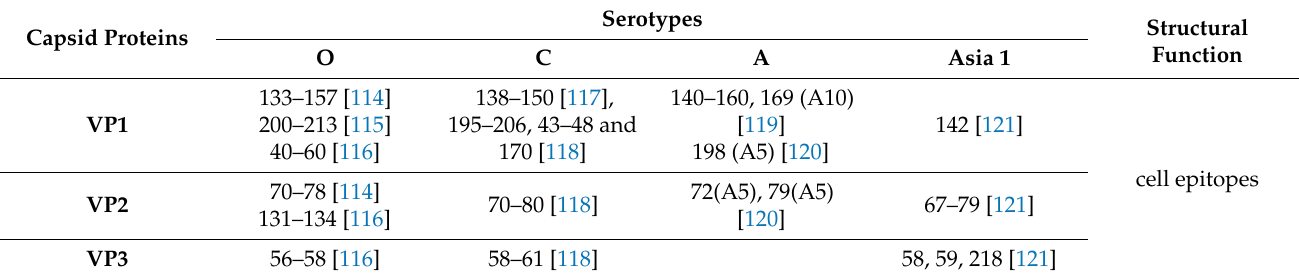
Table 3. Experimentally known neutralizing epitope regions of selected serotypes of